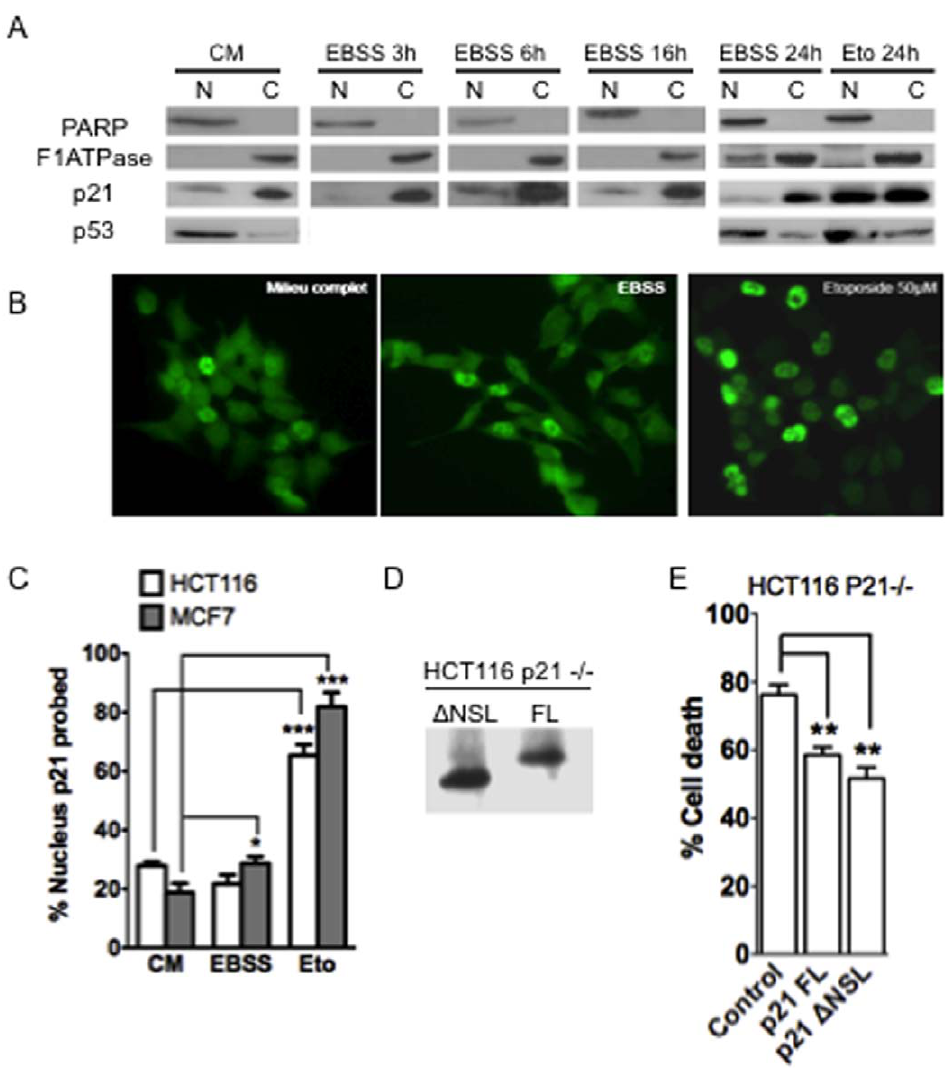
Figure 5. Impact of intracellular localization on the survival function of p21. (A) Nuclear versus cytoplasmic extracts prepared at the indicated times from HCT116 wt cells place under EBSS or not (CM), or treated with 50 m M of etoposide (Eto) for 24 h. Western analysis was performed for p21, p53 and F1ATPase and PARP. (B) Immunostaining of p21 in HCT116 wt cells placed under complete medium (CM), starved medium (EBSS) or treated with 50 m M of etoposide (Eto) for 24 h. Nucleus was stained with DAPI. (C) Quantification of immunostaining of p21 in HCT116 and MCF7 cells. The amount of cells containing a nuclear p21 localisation was expressed as a percentage of total cells detected with DAPI staining. (D) Western blot analysis of ectopic p21 in HCT116 p21 2 / 2 transfected with either pGFPires21FL expressing the full-length p21 protein (FL) or with pGFPires21 D NSL ( D NSL) expressing the p21 protein deleted from its C-terminal NSL domain. (E) HCT116 p21 2 / 2 transfected cells with the indicated vector were placed in EBSS medium and followed by time-lapse videomicroscopy. The vectors used allowed the expression of the GFP concomitant with p21, due to the presence of an IRES element. The percentage of transfected (ie GFP-expressing) cells exhibiting morphological features of cell death was assayed during 24 h. Data presented in (C) and (E) are mean 6 SEM of three independent